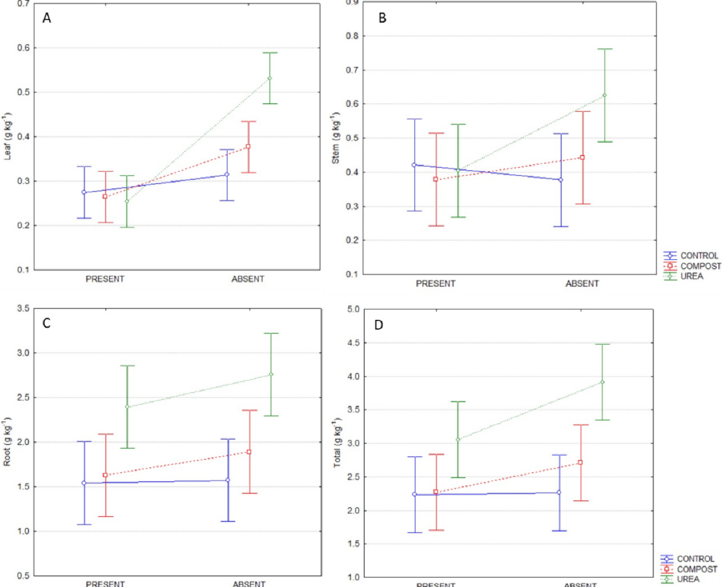
Figure 2. Nitrogen uptake in leaves ( A ), stems ( B ), roots ( C ) and total ( D ) from peach trees cultivated in pots with urea and organic compost application, in Paspalum notatum presence and absence. Two- way ANOVA. Tukey test at 5% probability. The values presented are averages of three replicates per treatment and the vertical bar represents the standard error.